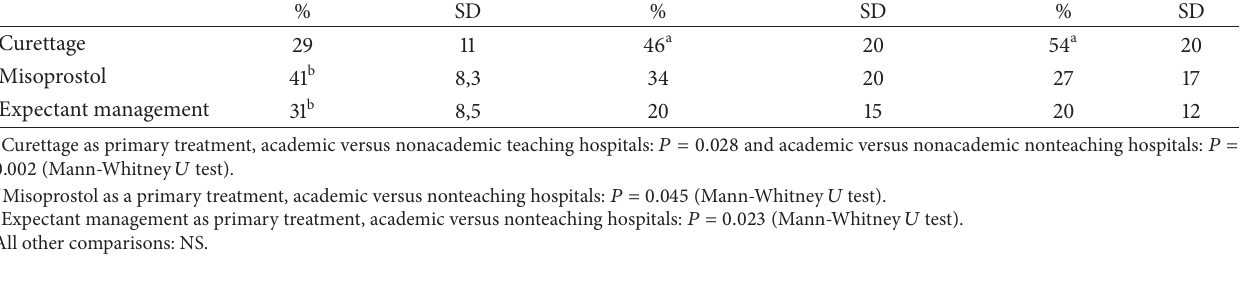
Table 2: The route of administration and dosage of misoprostol according to local